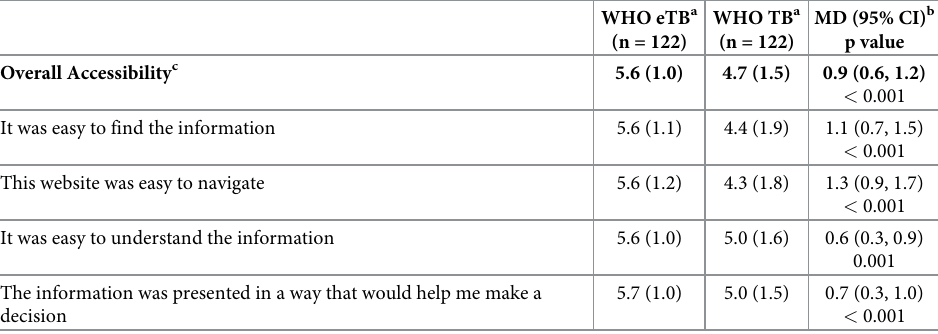
Table 3. Overall accessibility of information [mean (SD)].